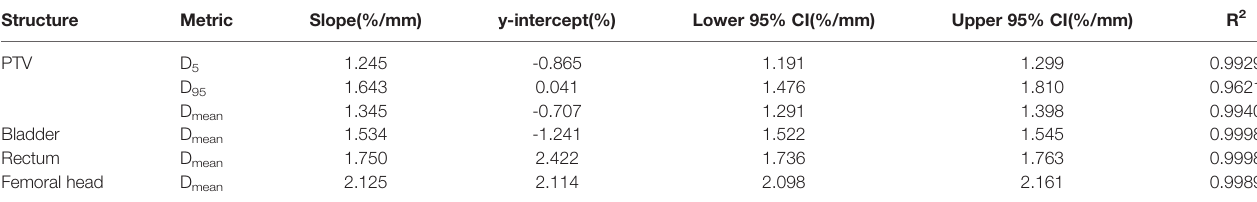
TABLE 3 | A list of the values obtained by linear regression for each structure.